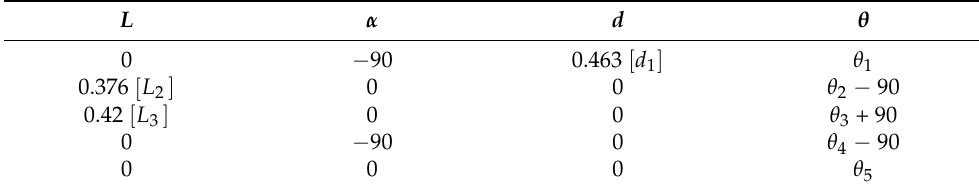
Table A1. DH Parameters of TAL BRABO Manipulator.